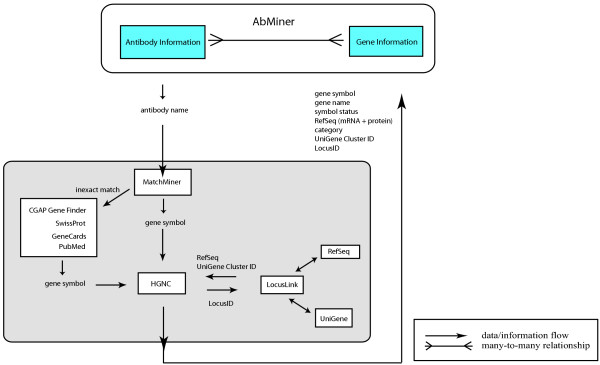
Pipeline for matching antibodies to gene identifiers. Antibodies were matched to corresponding gene symbols using MatchMiner or a combination of other resources if the symbol was not immediately retrievable with MatchMiner. The translation from symbol to LocusID was obtained from the Human Genome Nomenclature Committee (HGNC). LocusLink ftp -downloadable files provided UniGene Cluster Ids and RefSeqs. We then used the LocusID to join to the HGNC file, after which all identifiers could be mapped back to the antibody originally input into MatchMiner. The often-complex, many-to-many relationships between genes and antibodies are described in the text.